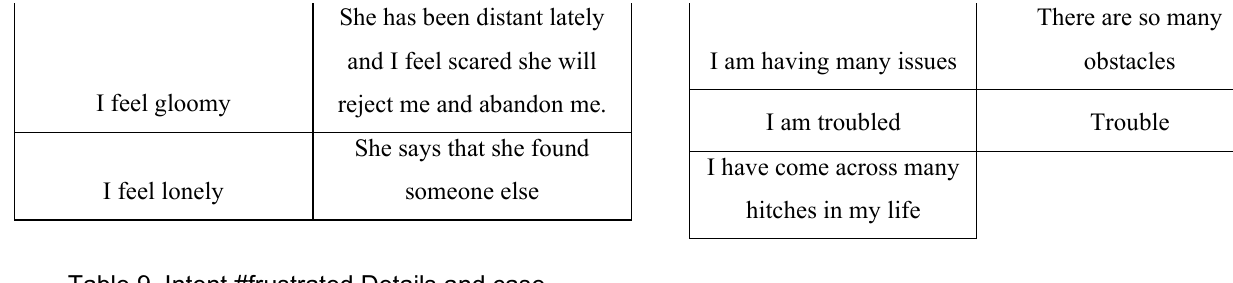
Table 9. Intent #frustrated Details and case examples configured